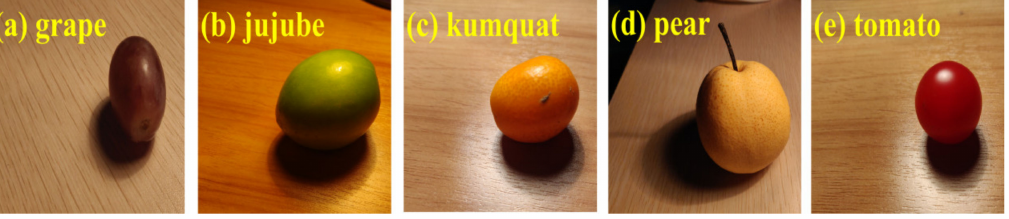
Figure 4. Experimental samples.